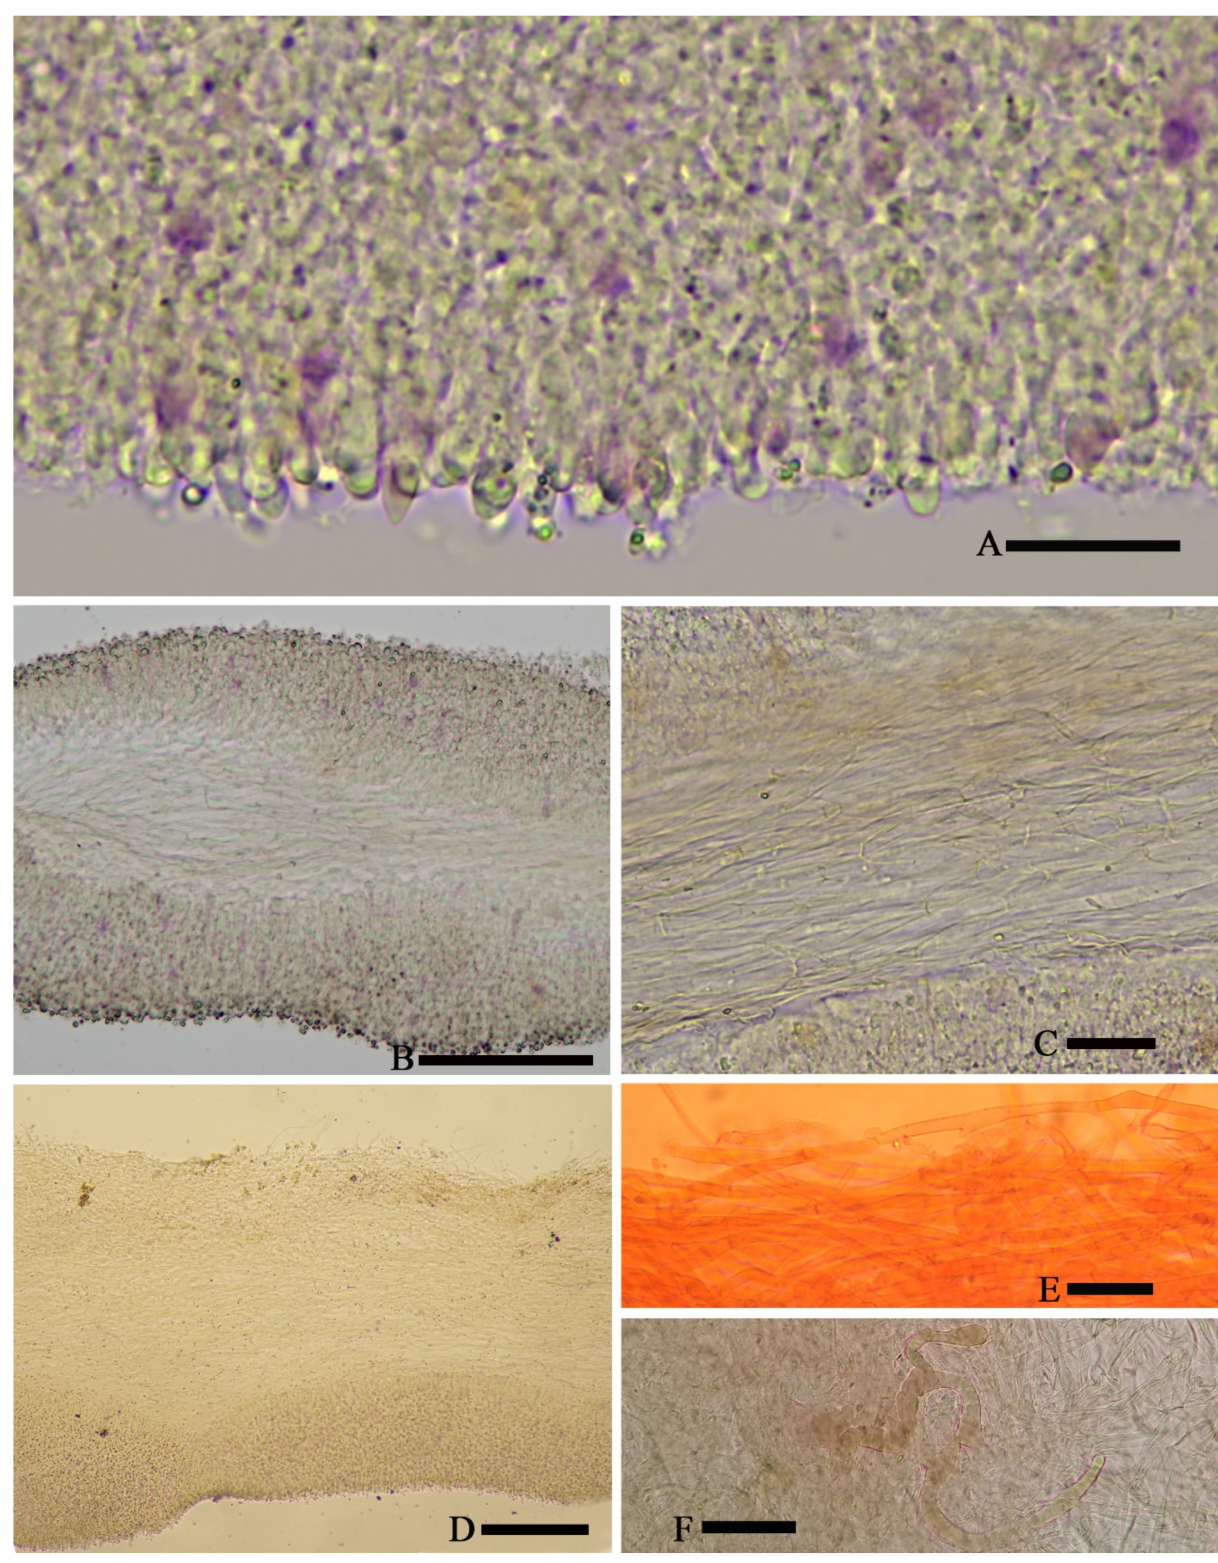
Figure 10. Microscopic features of Tricholosporum guangxiense, from HMJAU59028 (Holotype). ( A – D ) F in pure water, ( E ) stained with 1% Congo Red solution. ( A ) Margin of lamella, ( B , C ) Hymenophoral trama, ( D , E ) Pileipellis and Hyphae of Pileipellis, and ( F ) Laticifer. Scale bar ( A ) = 15 µ m, ( B ) = 5 µ m, and ( C – F ) = 20 µ m. Photos by Guang-fu